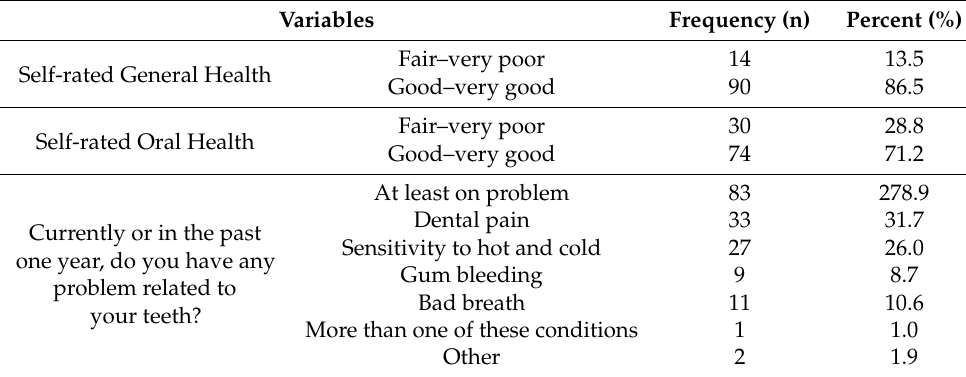
Figure 1. Oral health impact on daily activities and sports participation and performance in athletes (N = 104). Table 4. Self-reported oral health